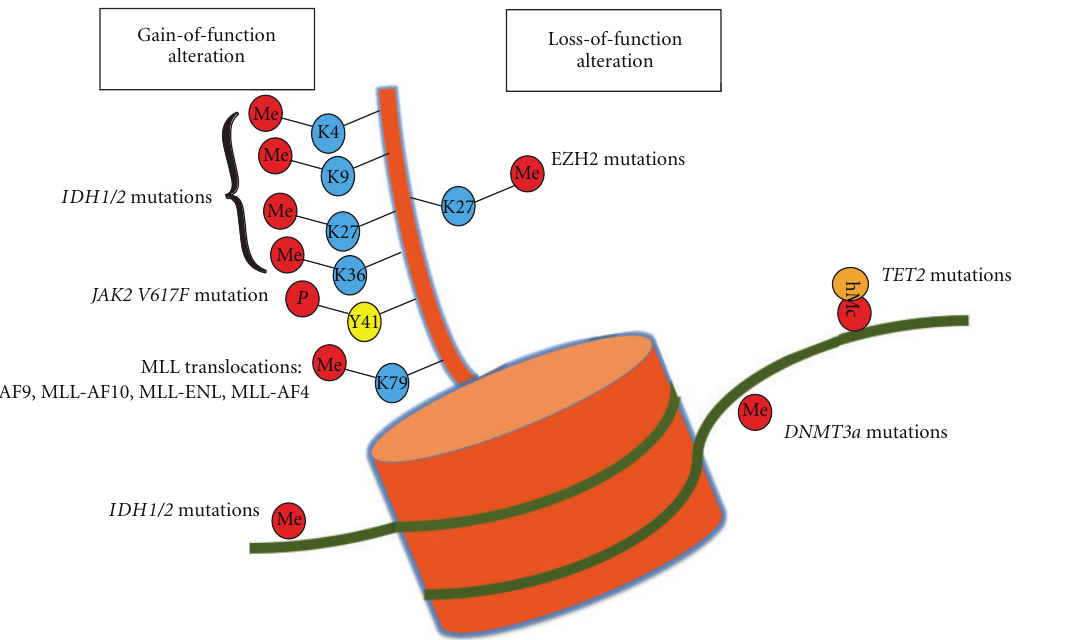
Figure 1: Specific histone and DNA posttranslational modifications shown to be associated with mutations in epigenetic modifiers in hematologic malignancies. Only genetic alterations which have some evidence for resulting in a gain or loss of function are displayed here. Mutations which result in the acquisition of hyperactivation or new enzymatic activity are displayed on the left of nucleosome while mutations which have evidence as resulting in a loss of enzymatic function are displayed on the right (translocations known to directly a ff ect histone posttranslational modifications are listed in Table 1). The majority of mutations in epigenetic modifiers in myeloid malignancies recently identified are known to a ff ect posttranslational modifications on the N-terminal tail of histone H3 or at cytosines of DNA as displayed here. Currently, the function of DNMT3a mutations in AML has yet to be extensively clarified, particularly the recurrent R882 heterozygous